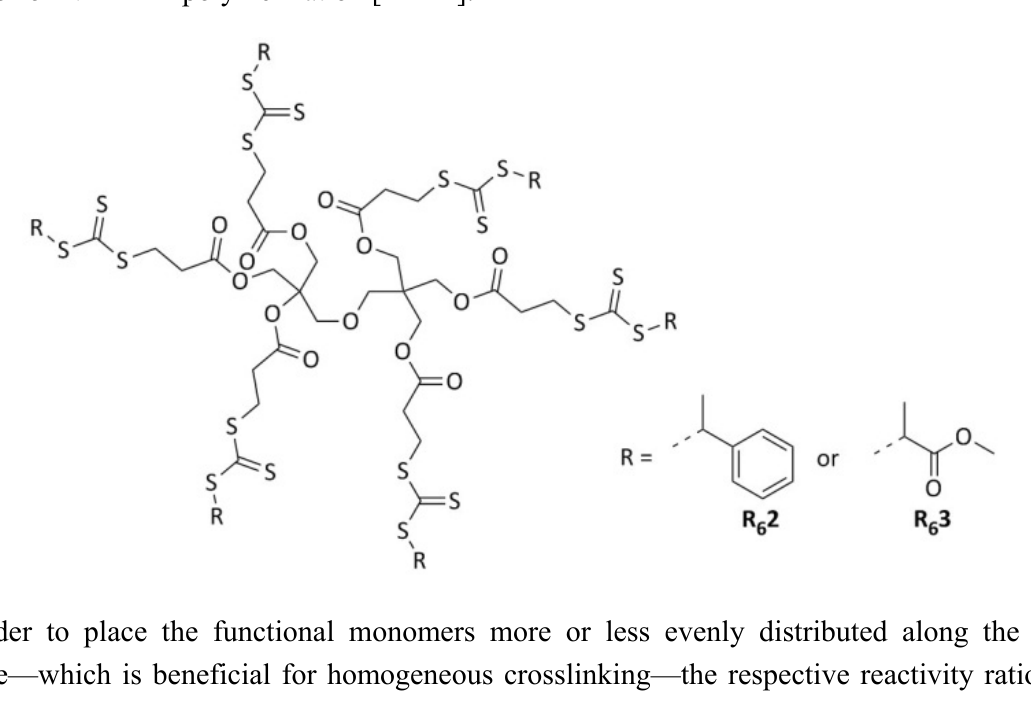
Figure 2. The RAFT agents dipentaerythriol-hexakis(3-S-phenylethyl-tricarbonylpropanoate) R 2 for BA and dipentaerythriol-hexakis(3-S-(methyl-2-propanoatotrithiocarbonyl)propanoate) 6 R 3 for NIPAAm polymerization 6